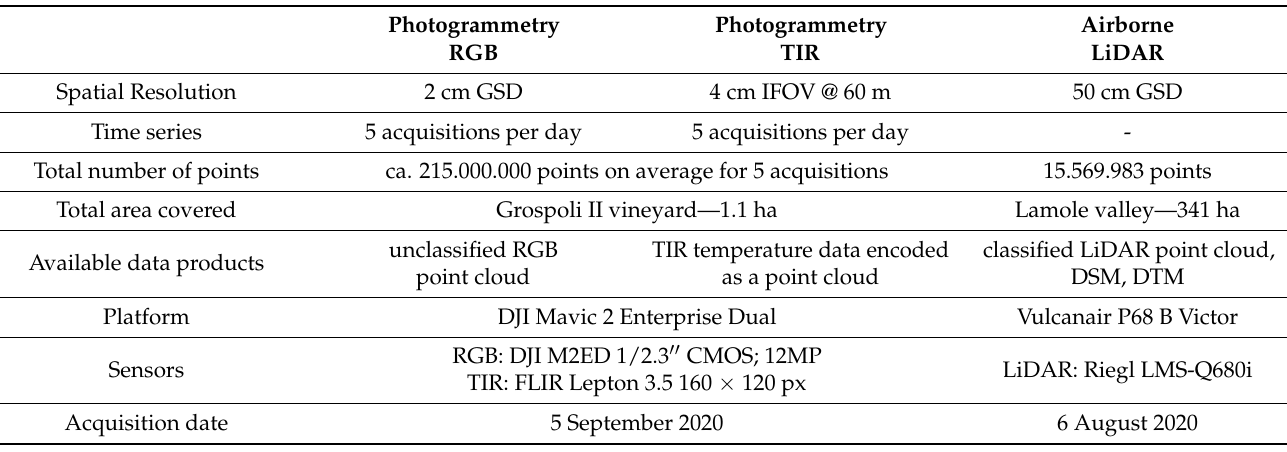
Table 1. Key parameters describing datasets used in this study. The spatial resolution was reported as ground sample distance (GSD) for RGB photogrammetry and LiDAR, and instantaneous field of view for TIR